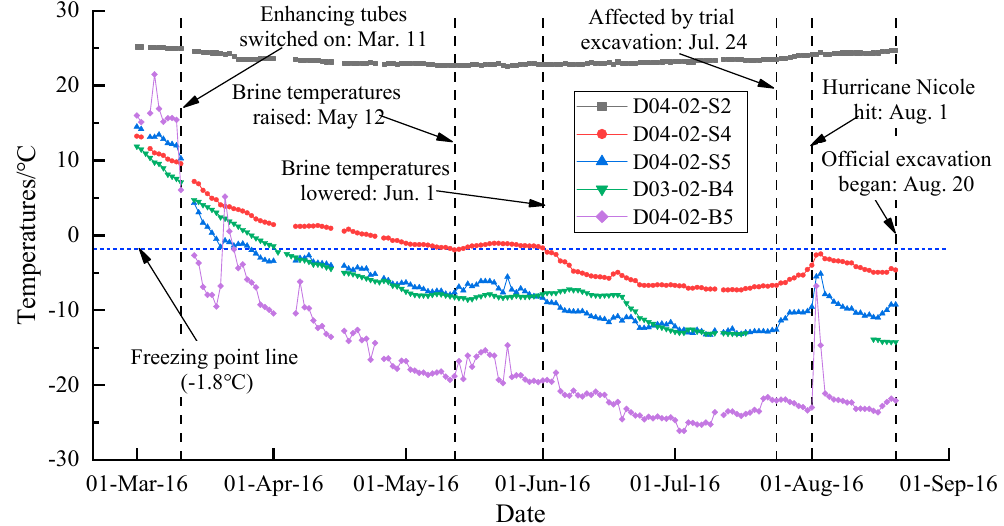
Figure 5. Temperature variation with time of measuring points at area A1 (see Figure 4).